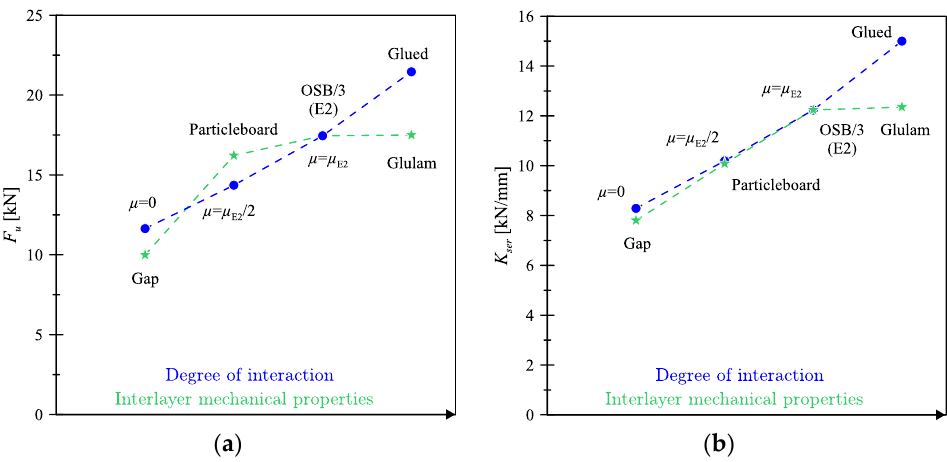
Figure 10. FE numerically predicted trends for ( a ) 𝐹 𝑢 and ( b ) 𝐾 𝑠𝑒𝑟 for different interlayer-to-members interaction and interlayer mechanical properties.